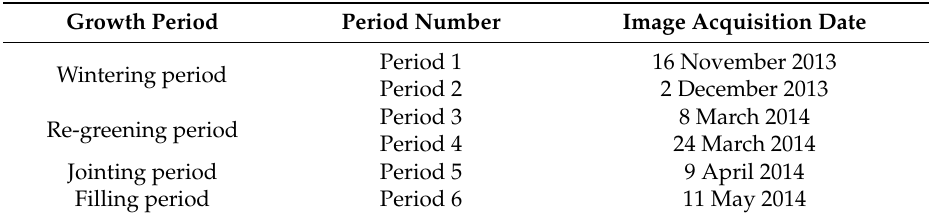
Table 2. Information provided by the images for disease monitoring.